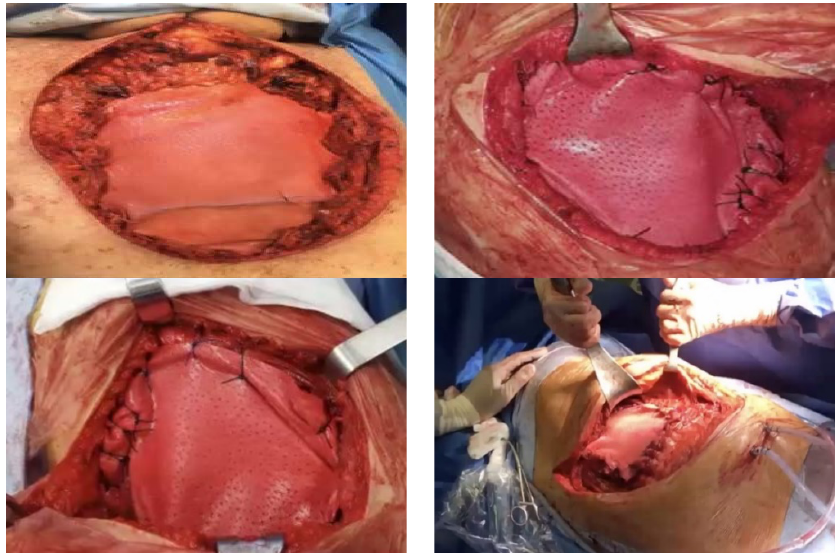
Figure 1. Acellular dermal matrix (Permacol; bovine dermis).